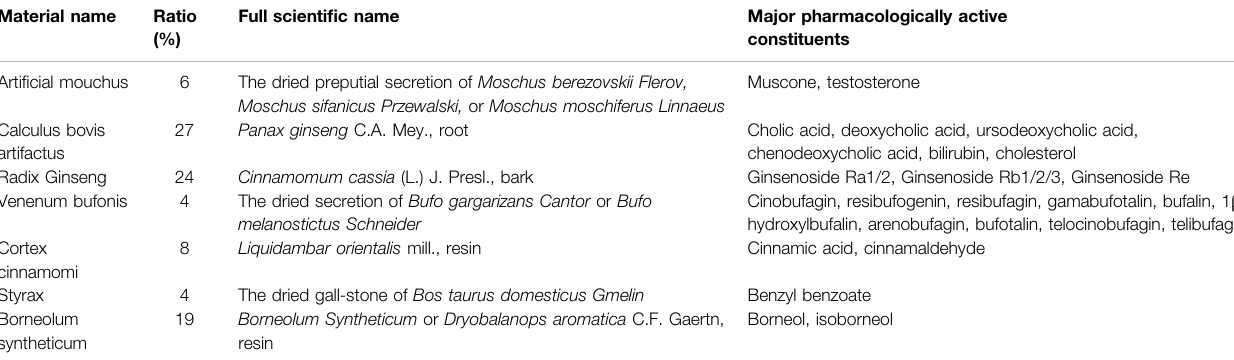
TABLE 1 | Individual medicinal materials of the